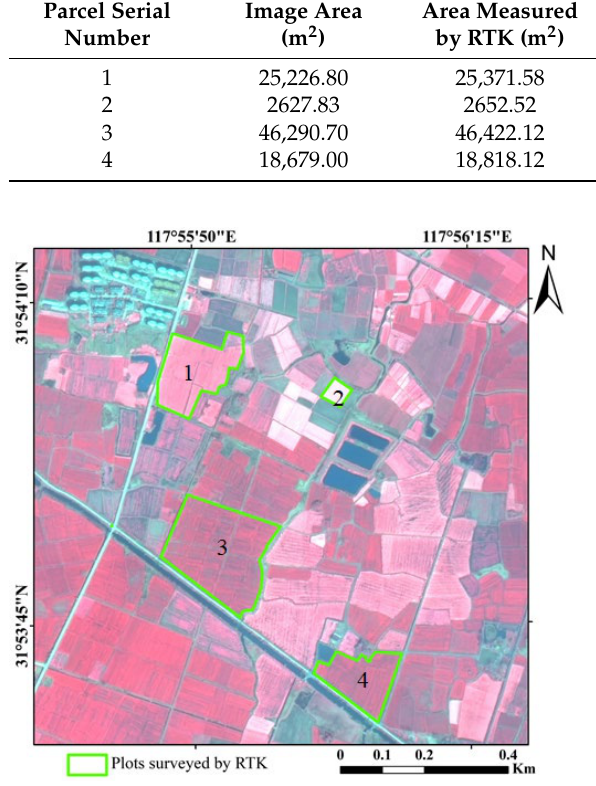
Figure 4. Manual carrying of RTK to measure the area of the plot (numbers 1 and 2 are rape planting sites, and 3 and 4 are winter wheat planting sites). Table 3. Error analysis of the actual measured plot area and remote sensing image area.